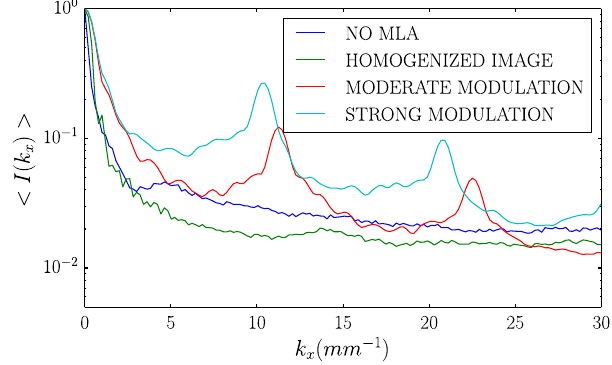
~ I ð k Þ for differ- x